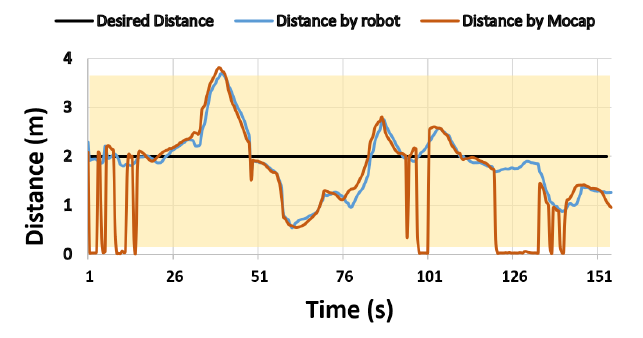
Figure 17. The relative distance between the person and the robot, estimated by the robot and the MoCap system in one of the FBM trials. The threshold for considering the robot to be following a person is indicated by the yellow area.